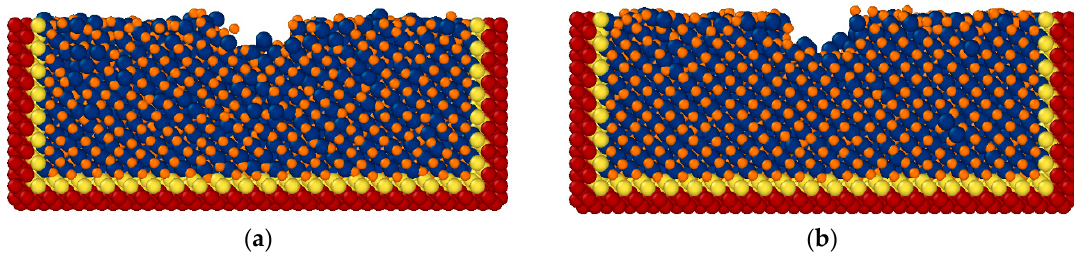
Figure 6. Molecular Dynamics Simulation Snapshot of Cavity Machined on SiC Substrate during ( a ) the LBMM Process and ( b ) LA-LBMM Process (Static Mode).